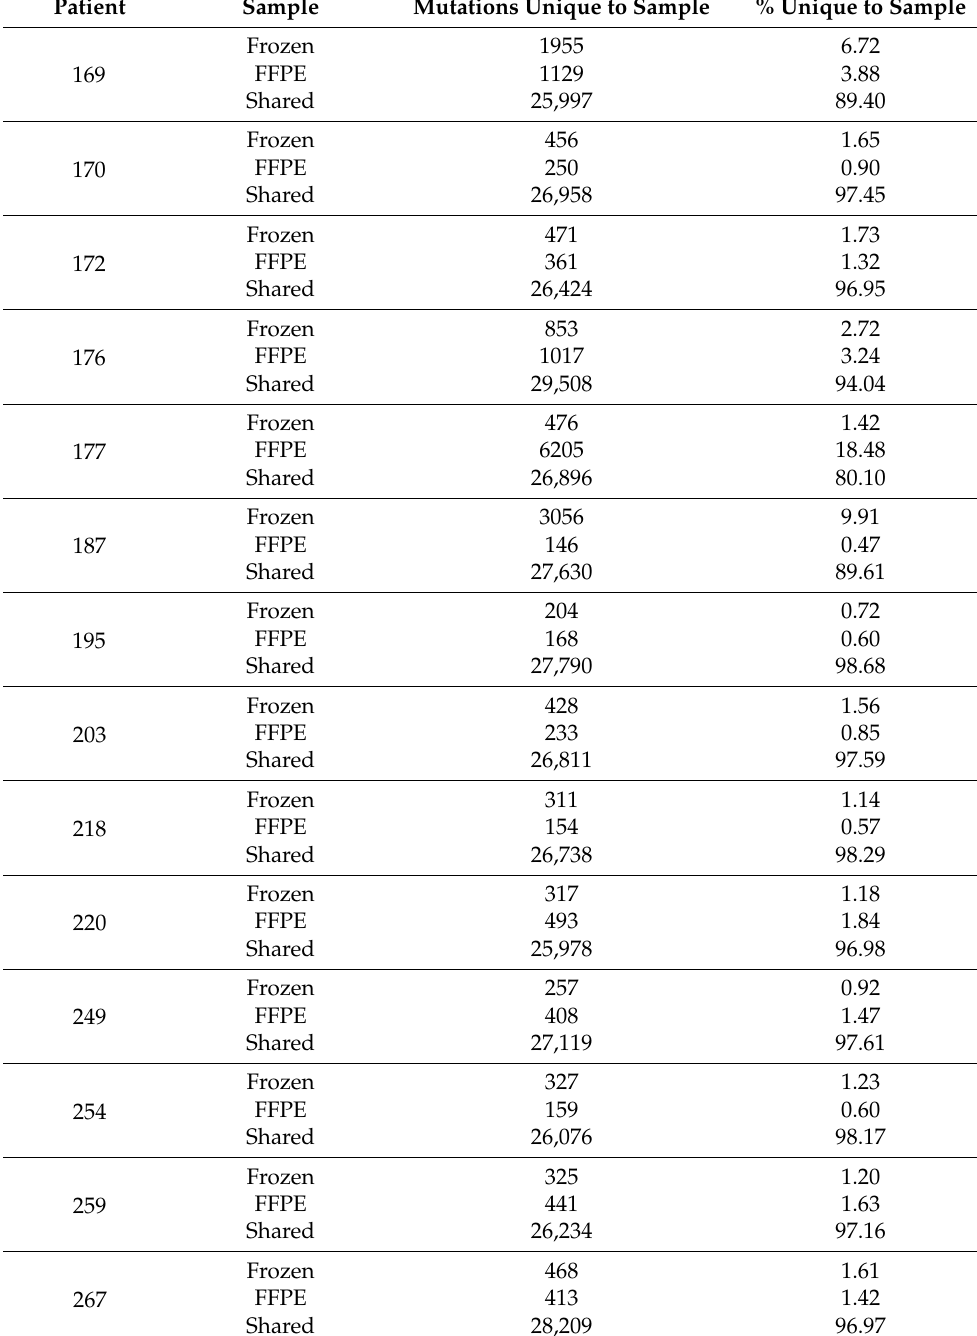
Table 3. The of percentage mutational concordance of matched fresh frozen and formalin-fixed paraffin-embedded (FFPE) gastro-oesophageal tumour